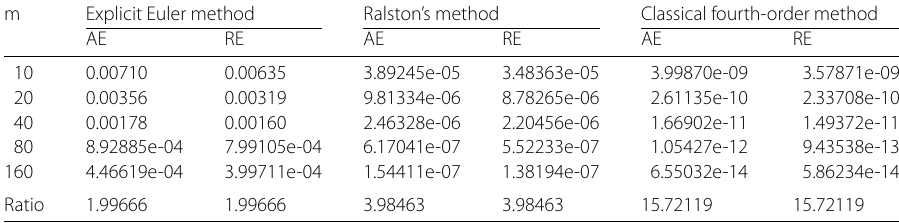
Table 2 The errors Runge–Kutta methods for